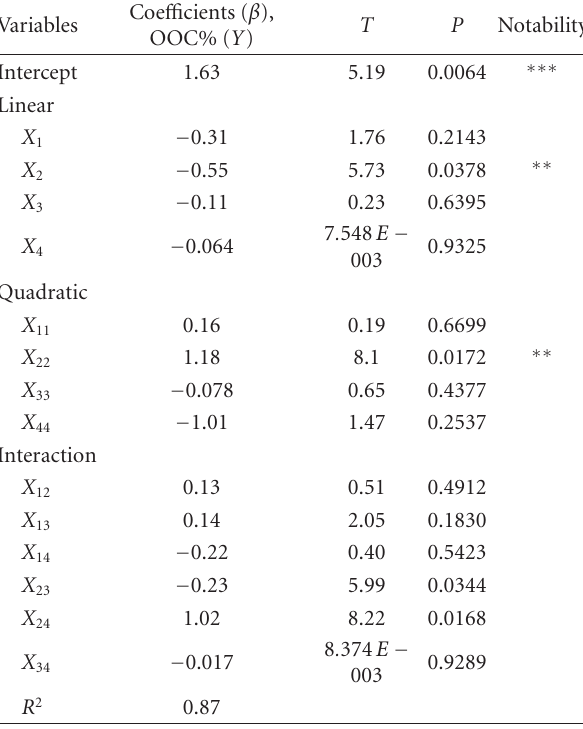
Table 3: Regression coe ffi cients of the predicted quadratic polyno- mial model for response variables of the OOC% of HYOOA.